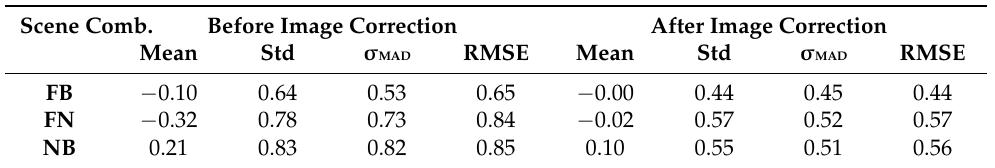
Figure 18. Section profile in the along-track direction with Z elevation differences of pairwise DSMs against the reference Lidar DTM before (square-dot lines) and after (solid lines) image geometry correction (to be compared with elevation corrections in Figure 14). Table 6. Accuracy assessment of Pléiades DSMs in open areas before and after image correction (RPC refinement with 300 GCPs; given values are in